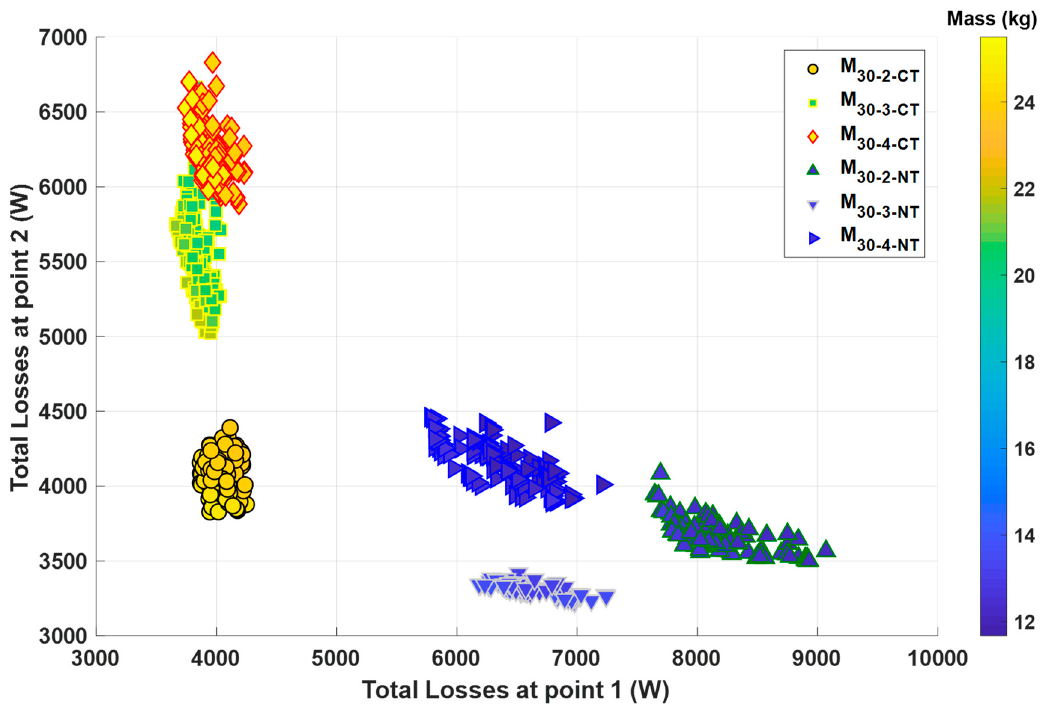
Figure 12. Pareto front of all electric machines operating at Ω (cid:3040)(cid:3028)(cid:3051) = 30 000 rpm .